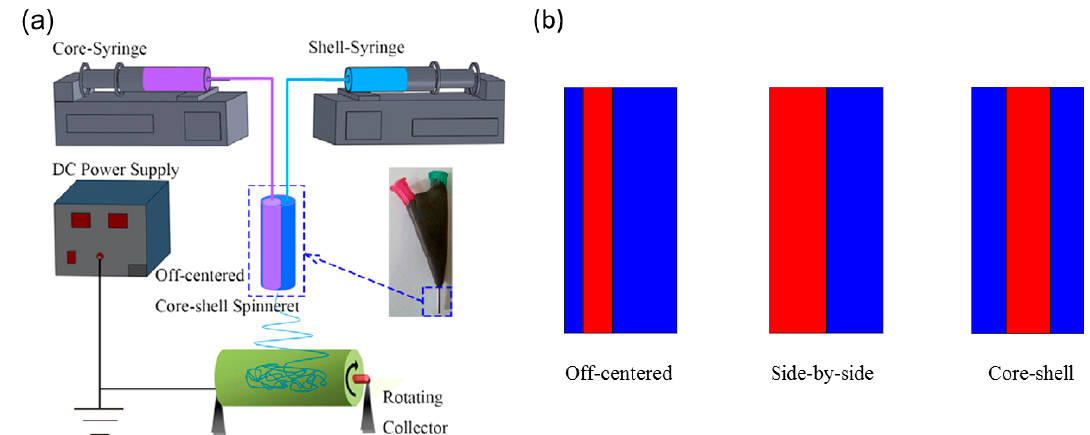
Figure 16. Schematic illustration of bi-component electrospinning setup and the internal structure of the electrospun fibers. ( a ) Schematic illustration of experimental setup of the bi-component electrospinning; ( b ) The schematic illustration of the off-centered, side-by-side and core-shell structure of the fiber. The blue and red represent different polymers. ( a ) is from [124], reprinted with permission, copyright (2015) American Chemical Society.